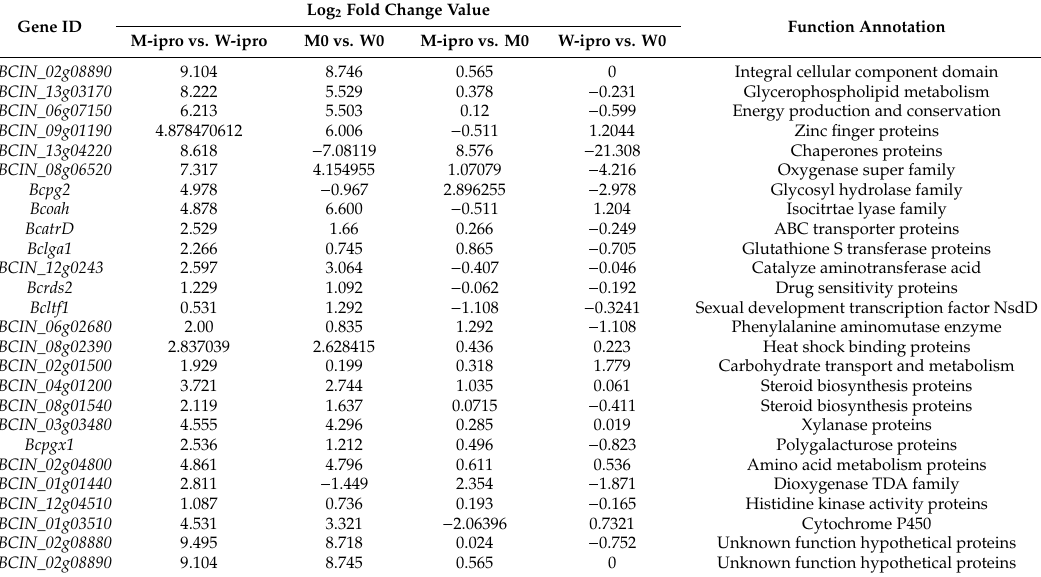
Table 3. Major genes related to resistance in B. cinerea wild type and its mutant with or without iprodione